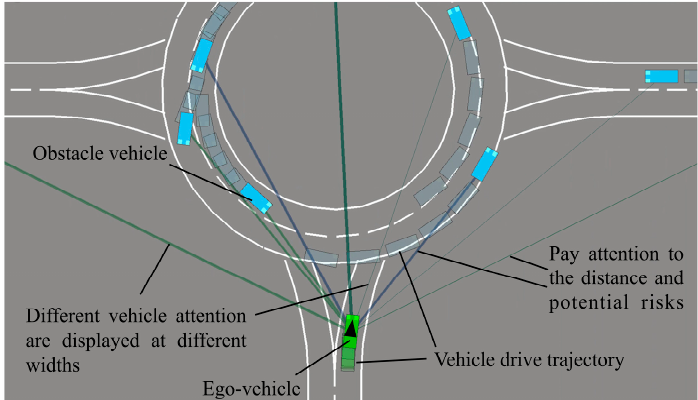
Figure 7. Attention distribution when ego-vehicle drives into the roundabout.